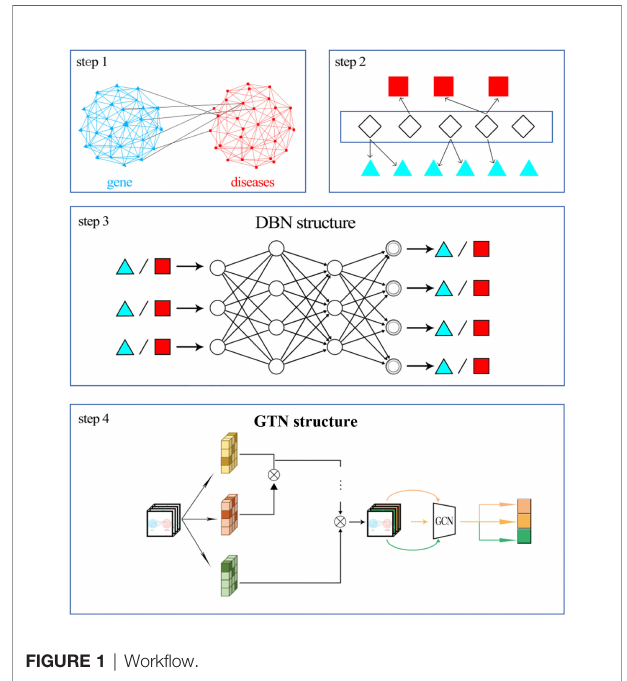
FIGURE 1 | Work fl